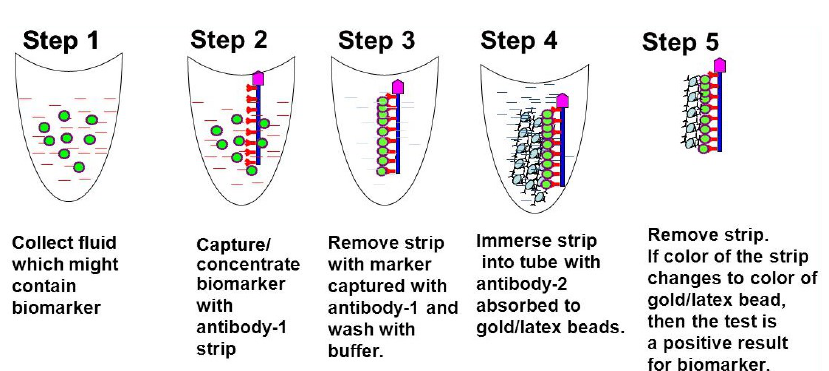
Figure 1. Point-of-care biomarker/disease/symptom detection kit: the kit consists of 3 parts. (1) A strip that is coated with a capture antibody (AB1) (either one side or both sides of the flat surface) that can bind to a specific biomarker in the body fluid that is tested. (2) A tube containing a solution to wash the strip so other proteins that stick to the strip nonspecifically can be removed. (3) A tube containing latex/nanogold adsorbed either/or polyclonal/monoclonal detection antibody (AB2), which is against the same biomarker protein. The test strips can be coated with multiple biomarker antibodies